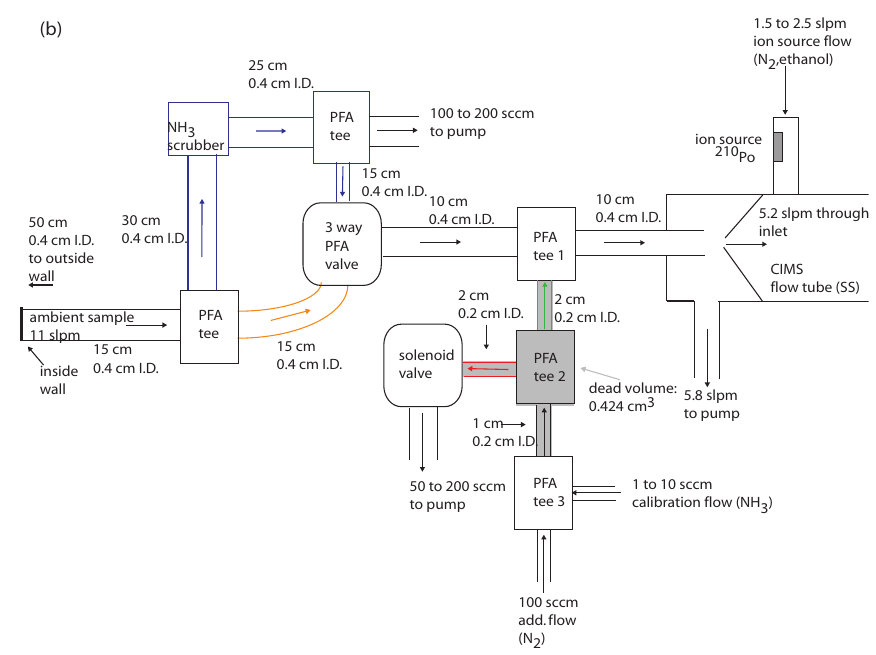
Fig. 1b. A schematic diagram of the inlet of KSU NH 3 -CIMS used in the fall 2009 measurements. The air entered through an inlet port (11slpm) and traveled through a PFA tee. The air flowed either directly through a 3-way PFA valve (measurement mode, orange arrow) or through an NH 3 scrubber and into the PFA valve (background mode, blue arrows). Calibration gases were introduced to the CIMS inlet system at the downstream of the 3-way valve. An additional flow (100sccm) of N 2 gases was also brought to the calibration system to mix with the standard NH 3 gases, to increase the time response with a high flow. This time response was affected by both the flow rate of gases and the dead volume (shown in the grey shaded area; estimated to be 0.4cm 3 ) in the tubing. When taking ambient or background measurements, the added calibration gases were removed by the suck back flow through a solenoid valve (red arrow), to reduce perturbation of flow. During the calibration, this solenoid valve was closed, so that calibration gases were introduced into the CIMS inlet system (green